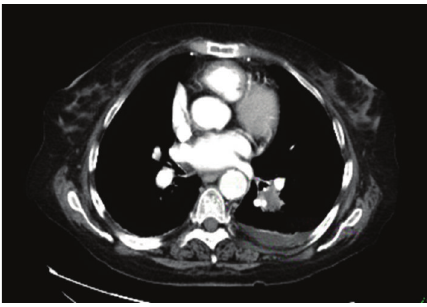
Figure 6: CT scan of the chest showing a spiculated mass in left lower lobe of the